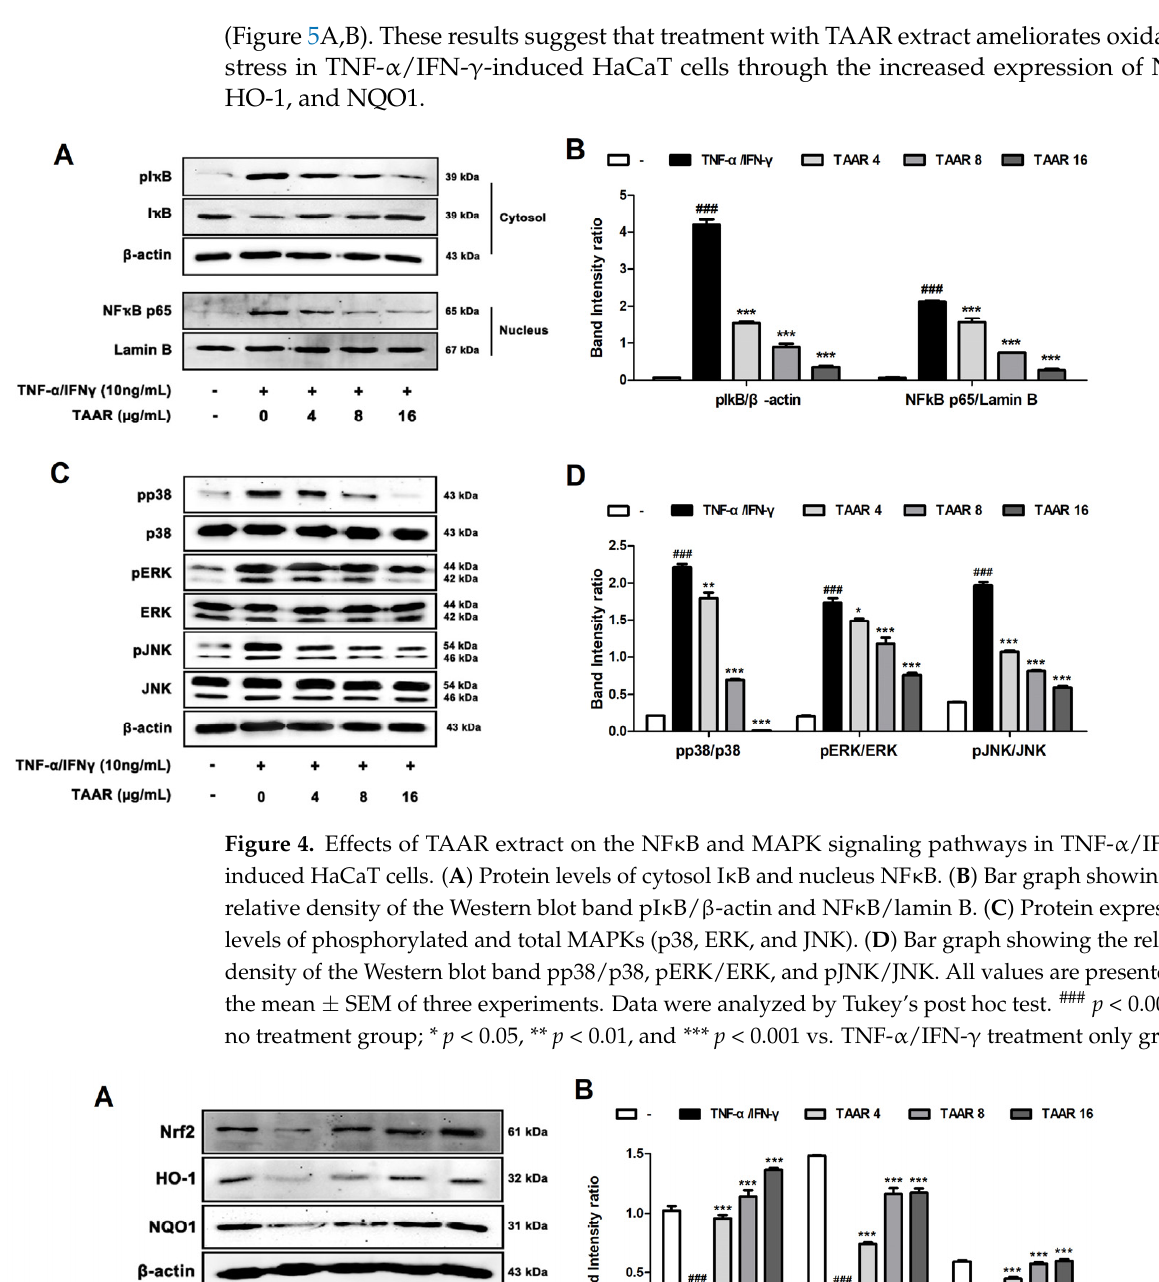
Figure 5. Effects of TAAR extract on the activation of the Nrf2/HO-1/NQO1 signaling pathway in TNF- α /IFN- γ -induced HaCaT cells. ( A ) Protein levels of Nrf2, HO-1, and NQO1. ( B ) Bar graph showing the relative density of the Western blot band Nrf2/ β -actin, HO-1/ β -actin, and NQO1/ β - actin. All values are presented as the mean ± SEM of three experiments. Data were analyzed by Tukey’s post hoc test. ### p < 0.001 vs. no treatment group; * p < 0.05, ** p < 0.01, and *** p < 0.001 vs. TNF- α /IFN- γ treatment only group.